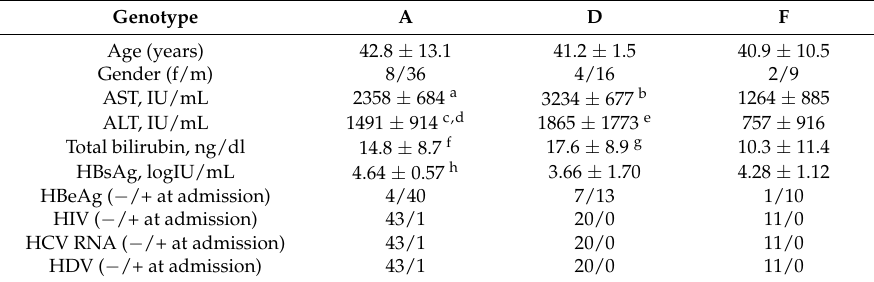
Table 1. Mean and standard deviation of age, anagraphical, biochemical parameters, and virological parameters in 73 acute hepatitis B infection (AHB) patients grouped by the most frequent genotypes (A, D or F). Two patients with genotype B and C virus were not included.